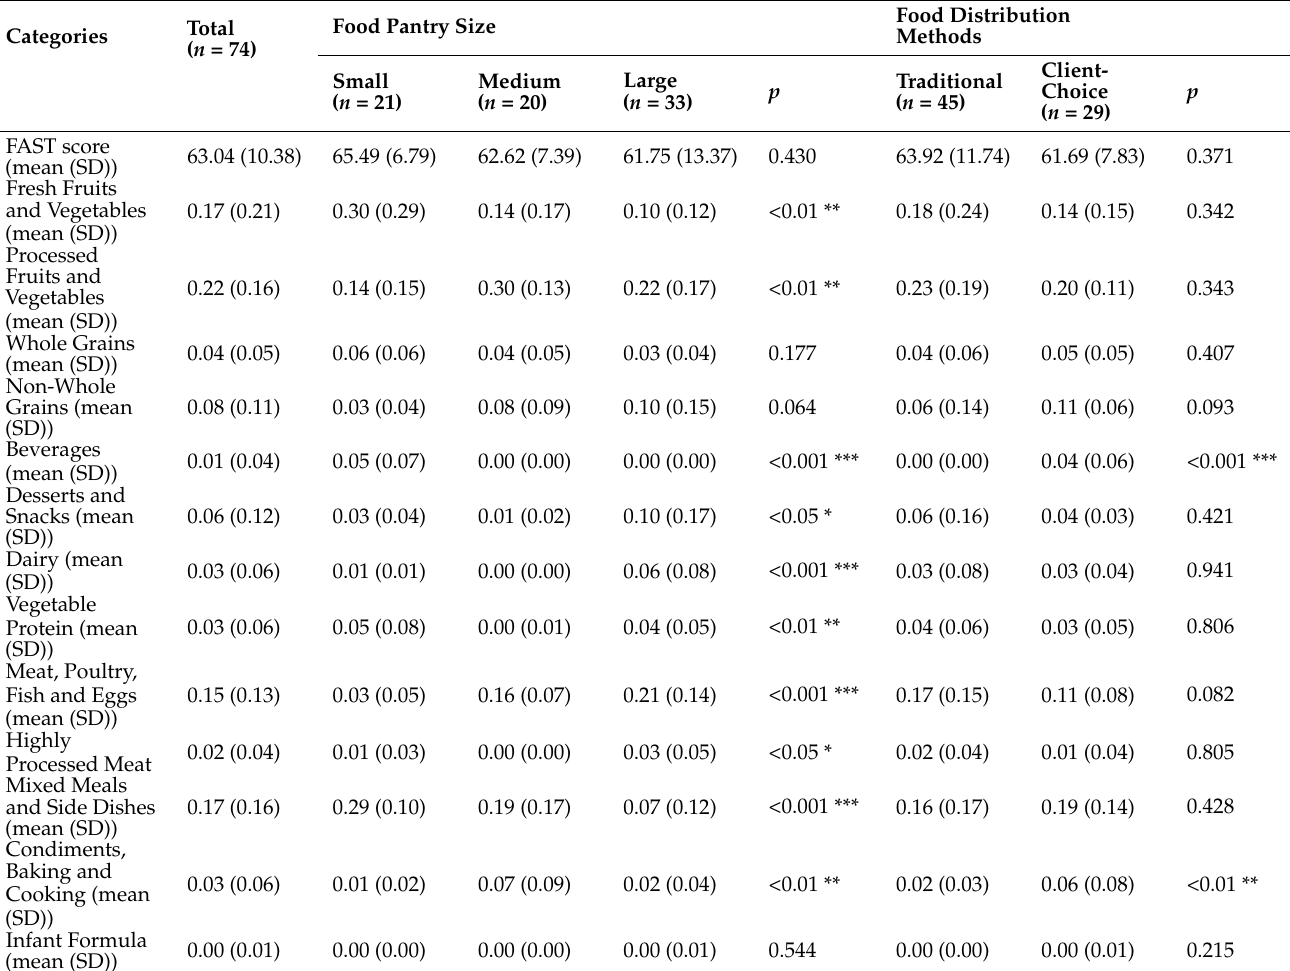
Table 4. Differences in GWS by pantry size and distribution